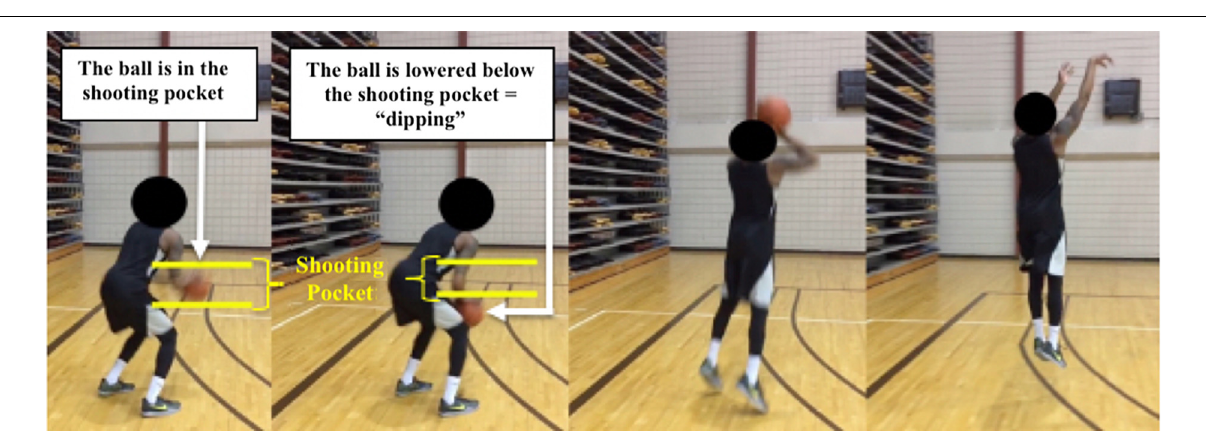
FIGURE 3 | University player shooting form illustrating the “Dip.” First frame: the player caught the ball and has placed it into his shooting pocket, indicated by the yellow bars, Second frame: the ball has been lowered below the shooting pocket (yellow bars), meaning the player has “dipped” the ball. Frames 3, 4: the player finishes the entire shooting